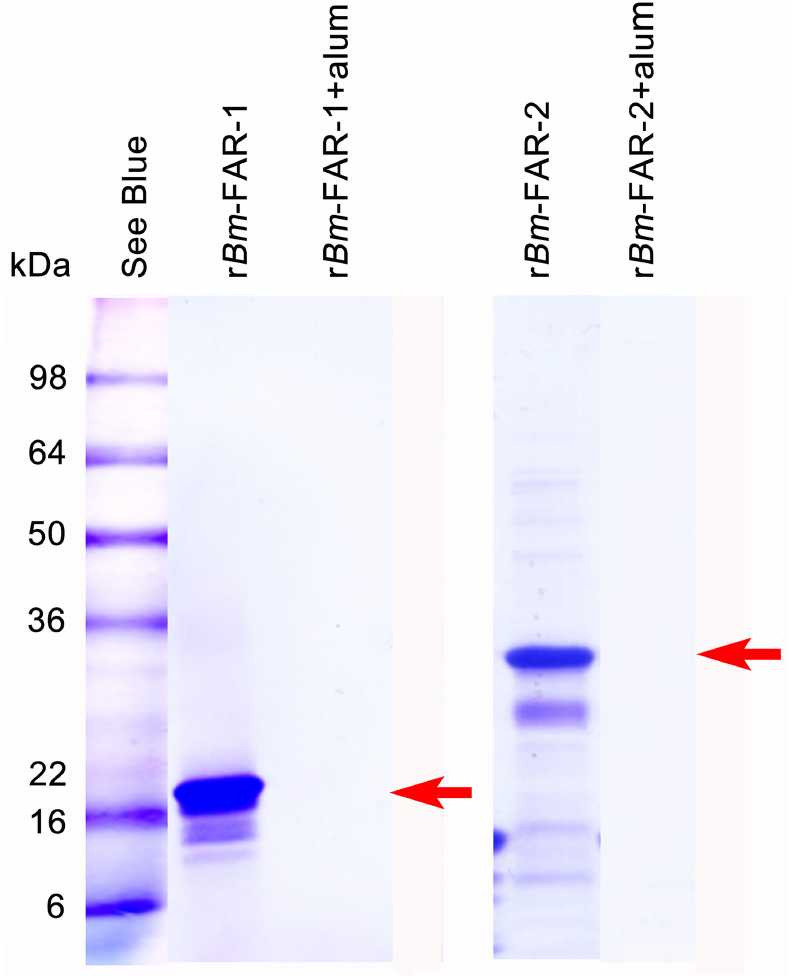
Fig 3. SDS-PAGE of yeast expressed r Bm- FAR-1 and E . coli expressed r Bm- FAR-2 and their binding to alum (Rehydrogel). Two μg of recombinant proteins were loaded in each lane (red arrow). The same amount of recombinant proteins was absorbed with Rehydrogel and the absorbed supernatant was loaded to adjacent well.